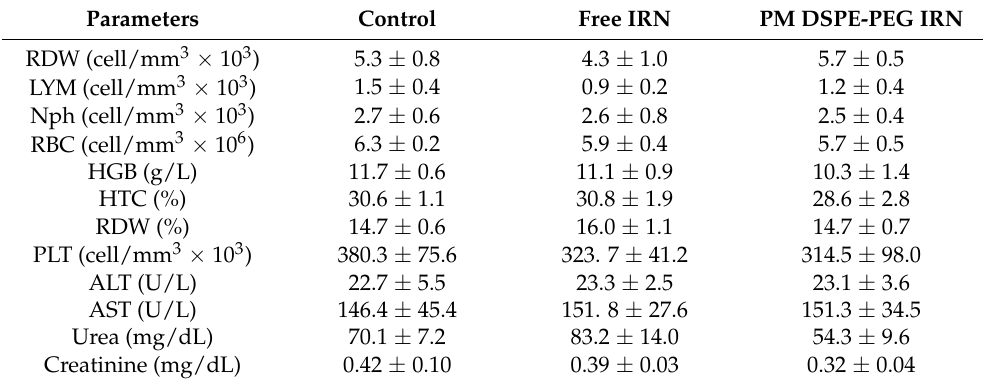
Table 4. Hematological and biochemical parameters of CT26 tumor-bearing BALB/c mice after different